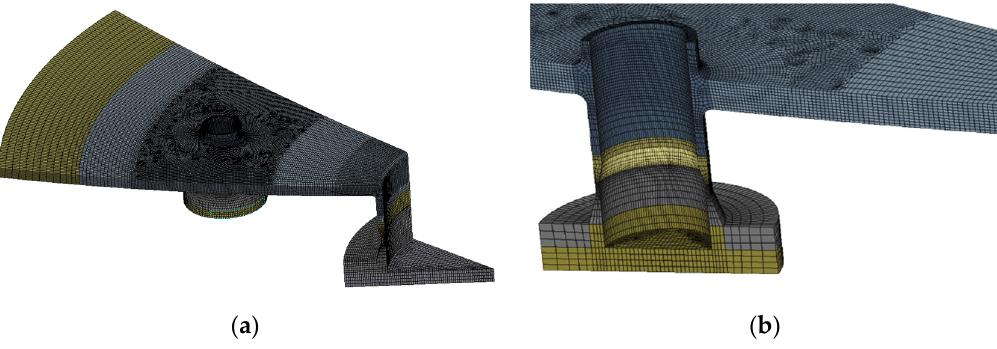
Figure 11. Solid element ( a ) general view, ( b ) detailed view of the stub.